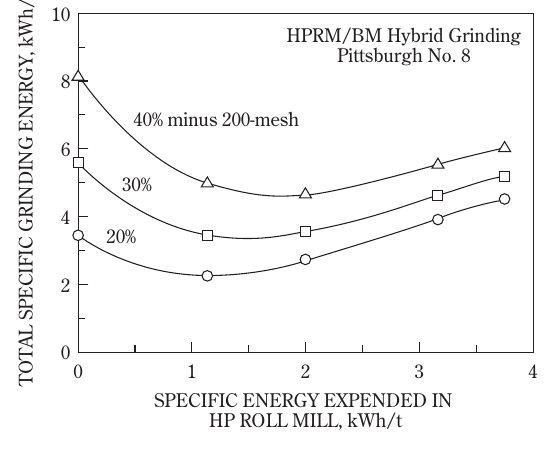
Fig. 13 Relationship between the total specific comminution en- ergy and the energy expenditure in the high-pressure roll mill for the production of minus 200-mesh fines in the hybrid grinding of Pittsburgh No. 8